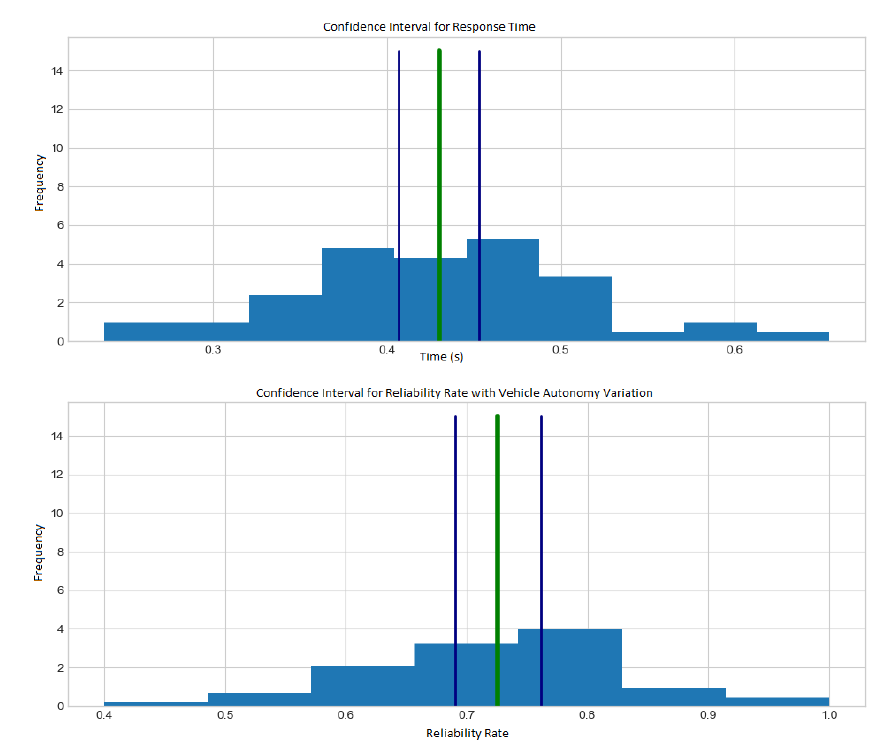
Figure 8. Histograms with response time and reliability ratio varying